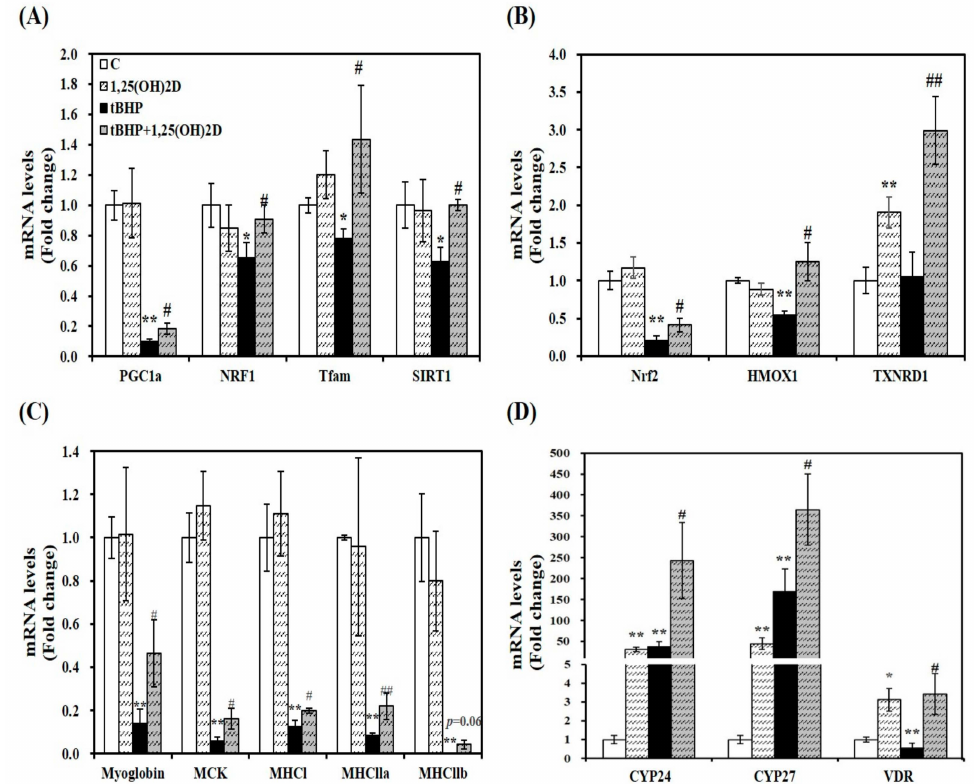
Figure 3. E ff ects of 1,25-dihydroxyvitamin D (1,25(OH)2D) on gene expression involved in mitochondrial biogenesis ( A ), antioxidant enzymes ( B ), myogenesis ( C ), and vitamin D metabolism ( D ). mRNA levels were determined by RT-PCR and normalized for all samples to β -actin. The value of each bar represents mean ± SEM. Experiments represent two independent experiments ( n = 8 per group). * p < 0.05, ** p < 0.01 compared to vehicle control. # p < 0.05, ## p < 0.01 compared to tBHP